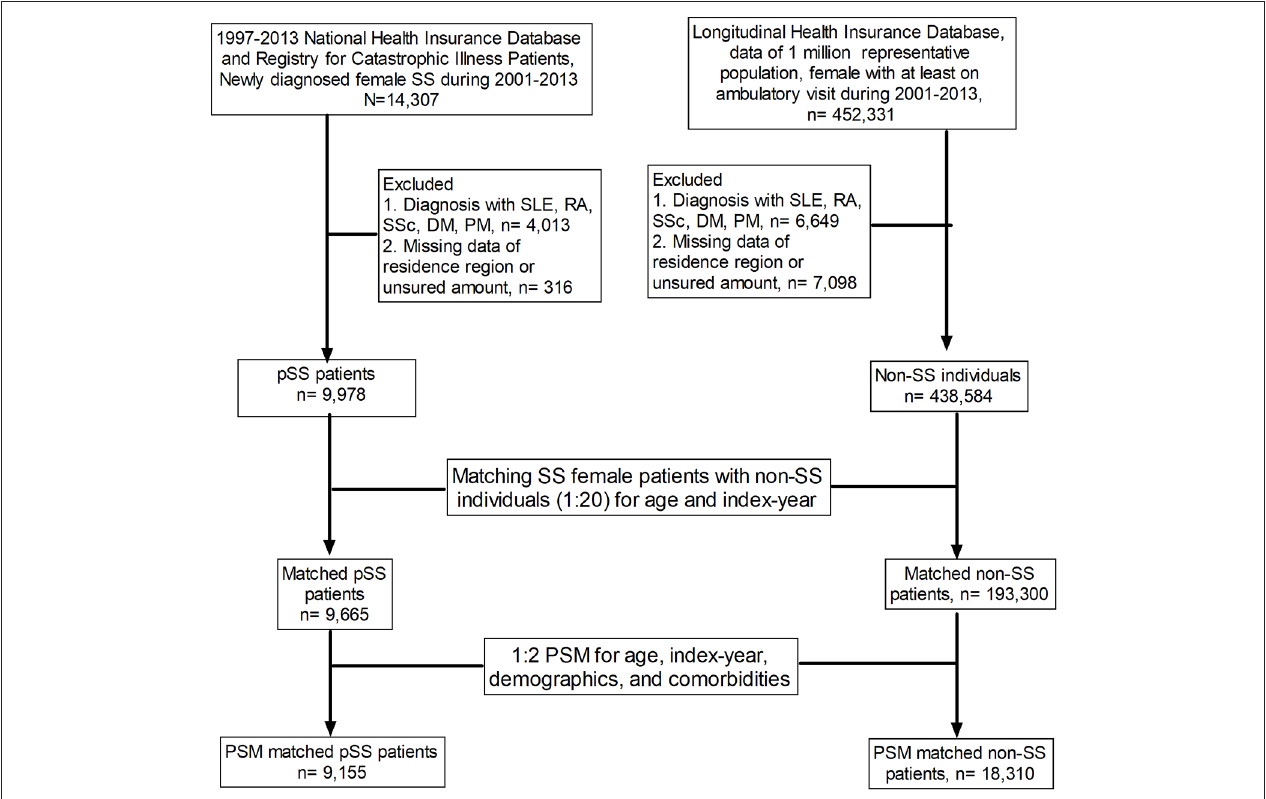
FIGURE 1 | Flow chart of the study design. SS, Sjögren’s syndrome; SLE, systemic lupus erythematosus; RA, rheumatoid arthritis; SSc, scleroderma; DM, dermatomyositis; PM, polymyositis; PSM, propensity score